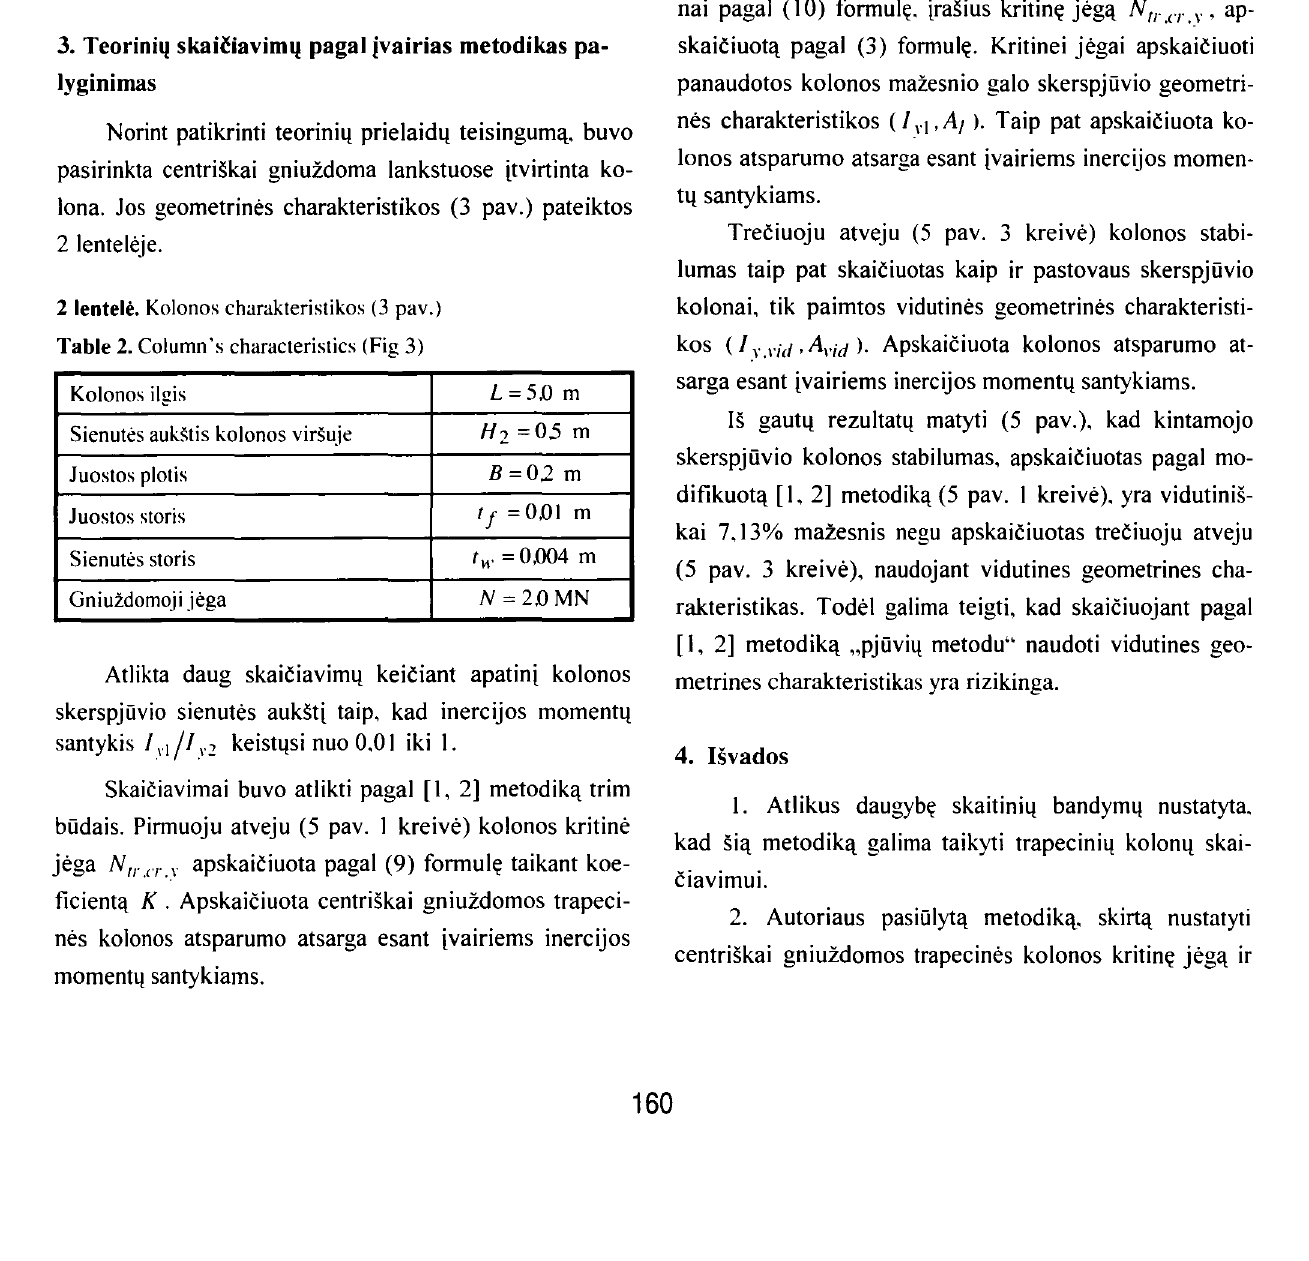
Fig 4. Factor's K values for pinned column Fig 5. Margin of stability, calculated according to Nagrinejant strypo pastovum~ plok~tumoje - kritin~ jeg~ galima skaiciuoti kaip ir pastovaus skers pjiivio strypui, nes inercijos momenttt santykis apie ::-:: = 1 (dvitejam skerspjii a~i yra artimas vienetui I :I/ I : 2